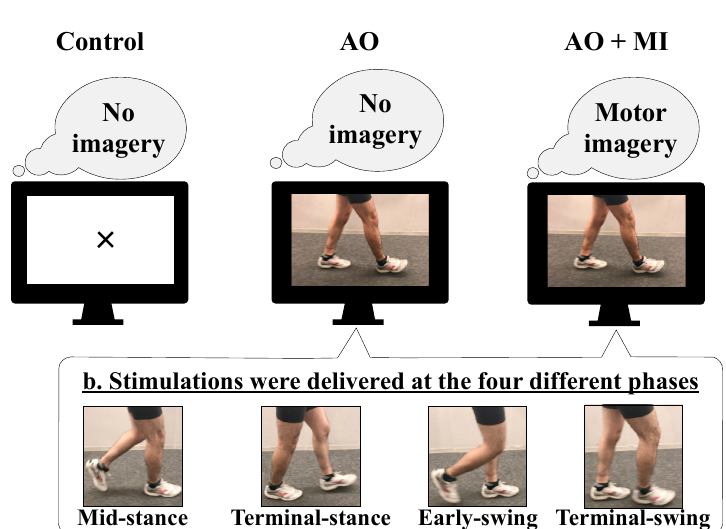
Figure 1. Experimental setup. ( a ) Spinal reflex parameters were determined for the following three conditions: control, action observation (AO), and AO with motor imagery (AO + MI). ( b ) In the AO and AO + MI conditions, electrical stimulation was randomly delivered during the following four phases: mid-stance, terminal-stance, early-swing, and terminal-swing.